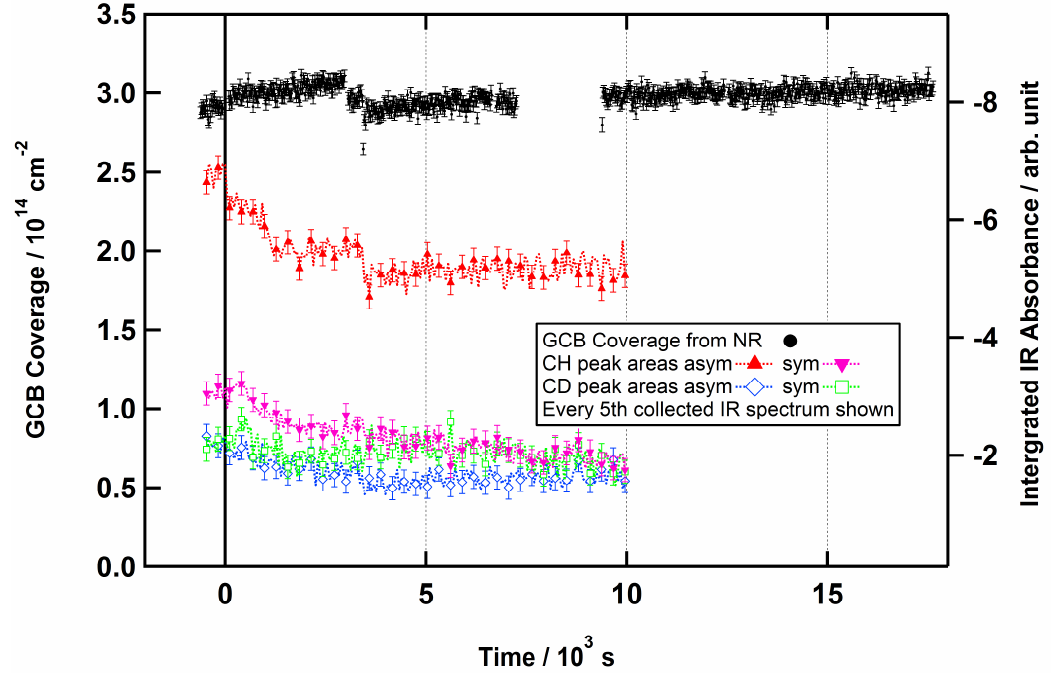
Figure 6. Oxidation of a GCB monolayer on pure water—neutron reflectometry (NR) (black circles and left ordinate) and infra-red reflection absorption spectroscopy (IRRAS) (coloured symbols and right ordinate) data as a function of time. We spread a monolayer of ~ 6.5 × 10 −5 L from a ~ 1 g L −1 spreading solution of d -GCB in CHCl 3 . NO 3 • was admitted at t = 0 s at a concentration of ~ 4.4 × 10 9 cm −3 . The integrated absorbance areas for the IRRAS data were calculated for 2110–2070 cm −1 and 2208–2178 cm −1 for CD bonds (one symmetric and one asymmetric stretch; coloured squares and diamonds) and for 2868–2833 cm −1 and 2945–2898 cm −1 for CH bonds (one symmetric and one asymmetric stretch; coloured triangles).